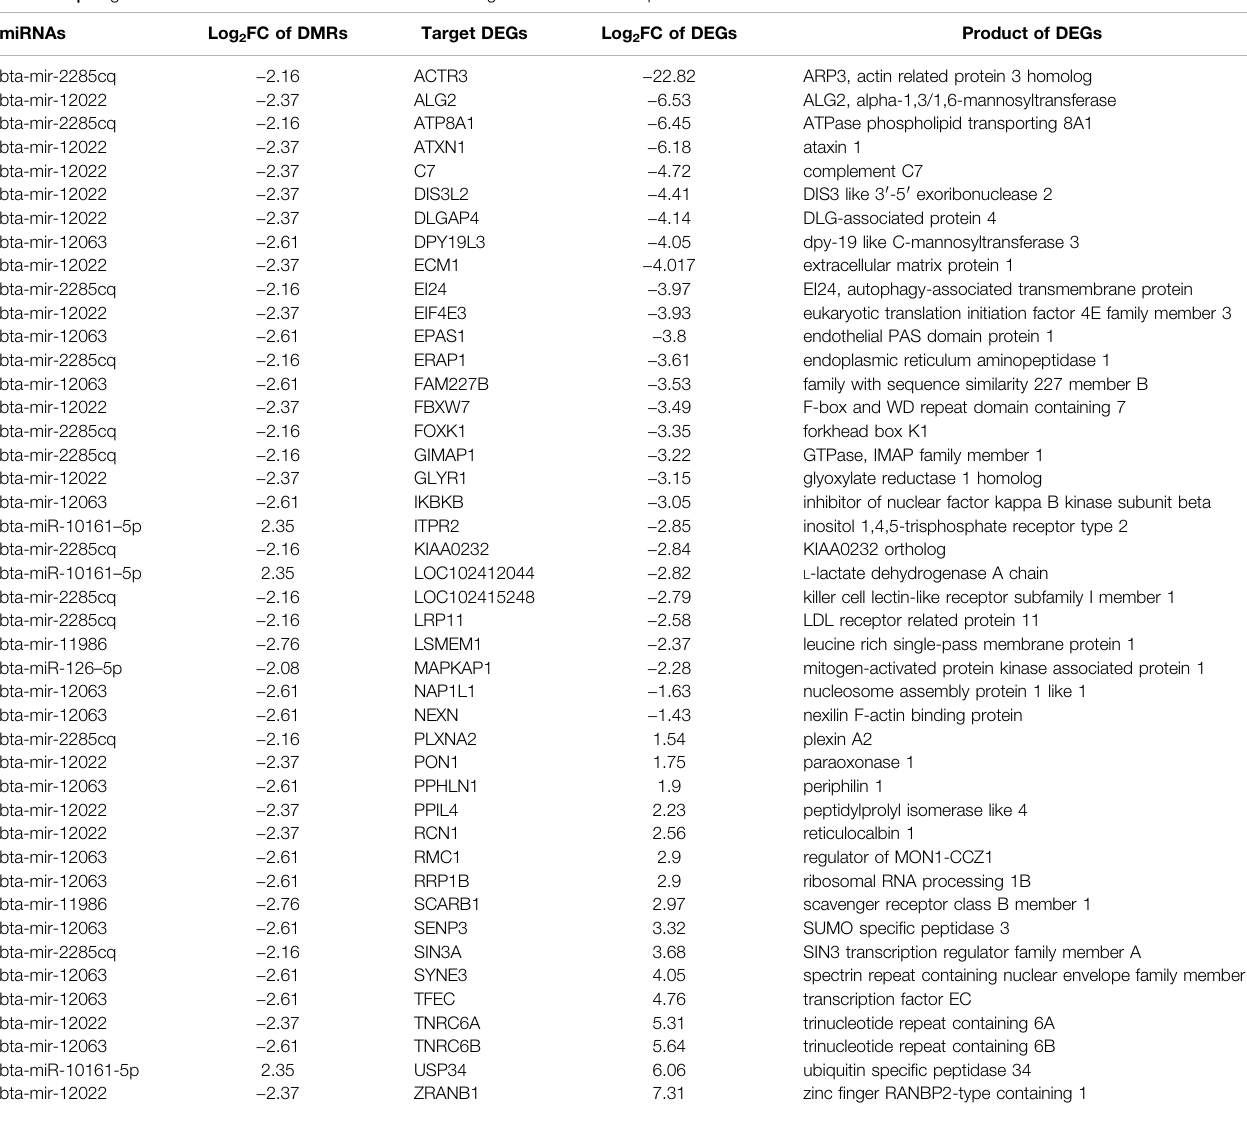
TABLE 5 | Target DEGs of miRNAs transcribed from DMRs along with their encoded proteins. miRNAs